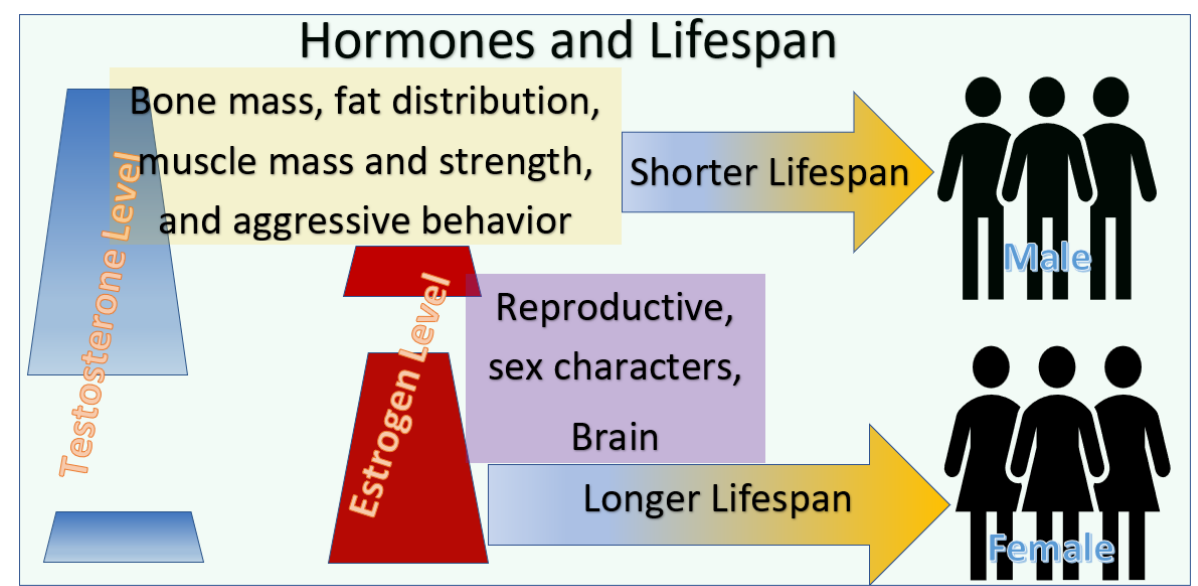
Figure 1. A simplified model of the levels of hormones and lifespans between sexes. Males have a shorter lifespan than females. The significant difference between the males and females is that the level of testosterone level in males is much higher than in females and the estrogen level in females is much higher than that in males.